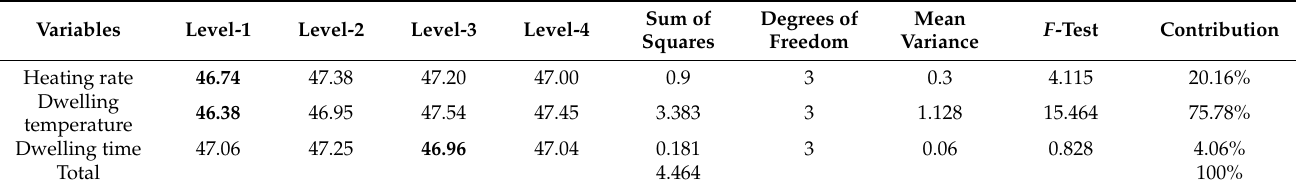
Table 4. ANOVA of SNR value.